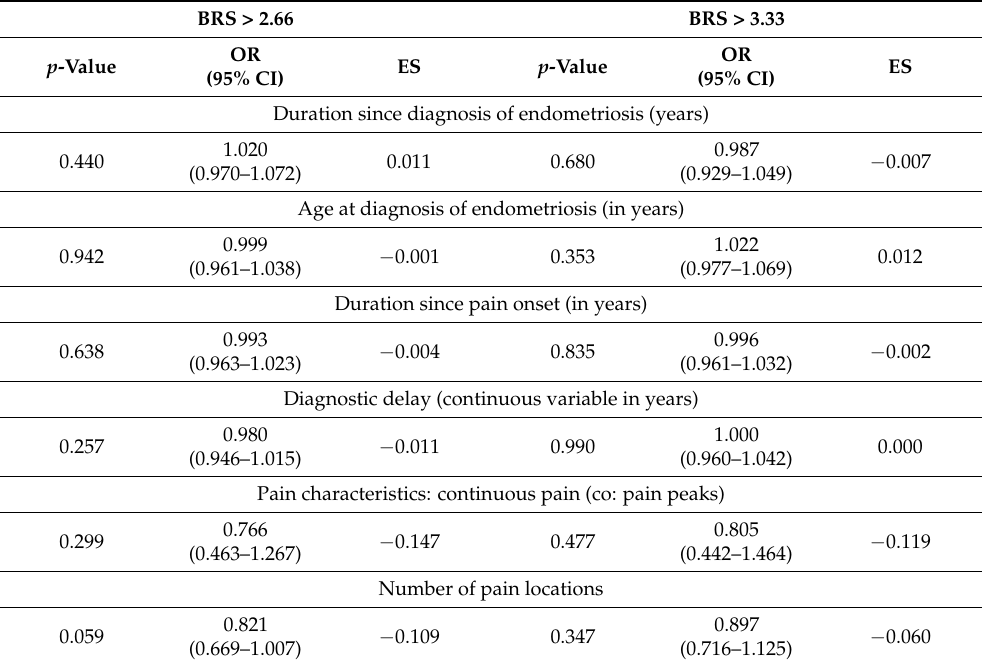
Table 4. Influence of endometriosis-specific history on self-reported mental health outcomes (univari- ate logistic regression analysis).